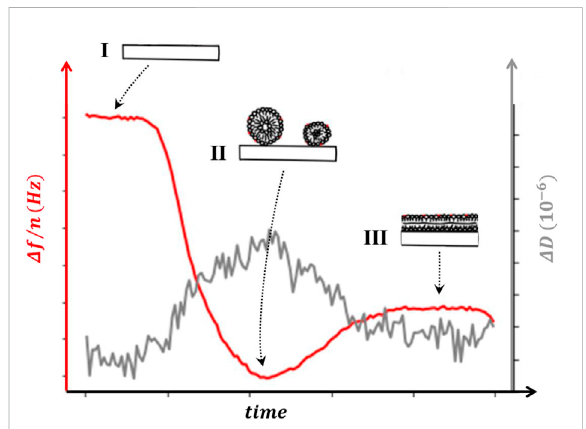
Sensogram. The change in frequency Δ f/n (left axis) and dissipation Δ D (right axis) as a supported lipid bilayer (SLB) is formed from vesicle fusion. The regions depicted (I, II and III) illustrate the con fi gurations of the sample that can account for the changes observed in sensogram signal. (I) the chamber is fi lled with the desired buffer and frequency and dissipation shifts are taken as reference for the rest of the experiment. (II) intact liposomes adsorbed on the surface shift both Δ f/n and Δ D. (III) liposome rupture releases water, reducing both the frequency change and the dissipation, as the lipids spread on the surface to form the